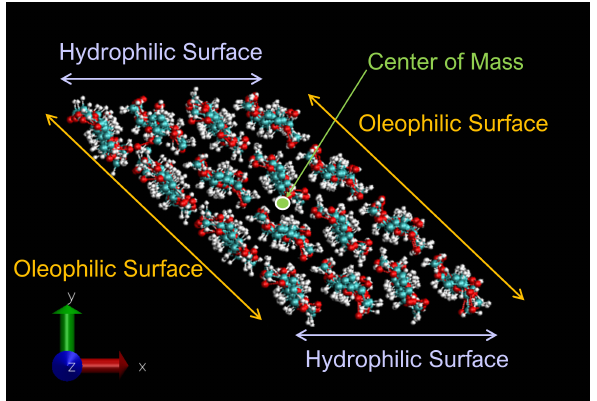
Figure 2. Cellulose nanocrystal consisting of 4 × 4 cellulose chains; cross-sectional view. The orientational angle θ z = 0 for this